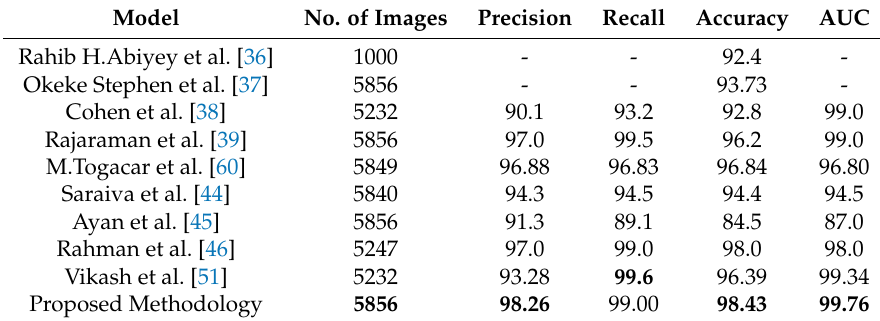
Table 7. Comparison of the proposed methodology with different existing